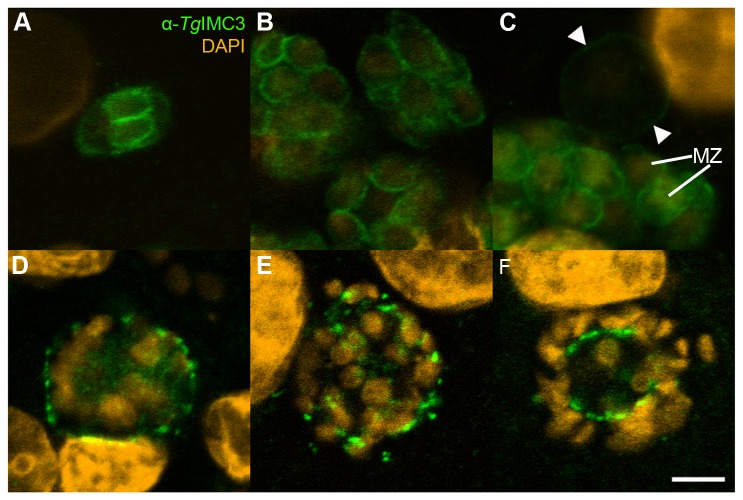
Immunohistochemical staining of

I

. suis
 stages with anti-TgIMC3 and DAPI.Staining with anti-TgIMC3 is shown in green, DAPI-staining is depicted as orange; (A) Type I meront, dpi 8; (B) merozoites, dpi 8; (C) merozoites and a weakly stained macrogamont indicated by arrow heads, dpi 8; (D), (E) presumptive early microgamonts, dpi 11; (F) mature microgamont with microgametes surrounding the residual body, dpi 11; dpi, days post infection; bar = 5 µm.